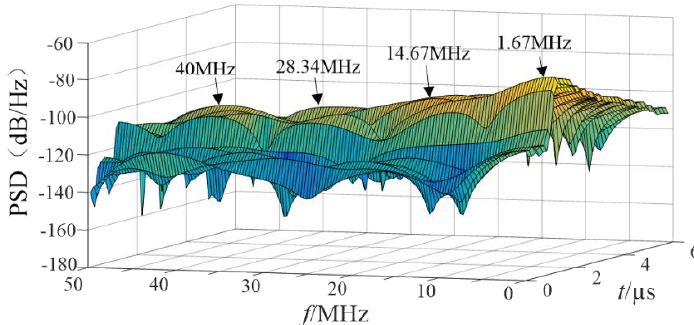
Figure 13. Power spectrum of simulated magnetic field intensity (2 mm).